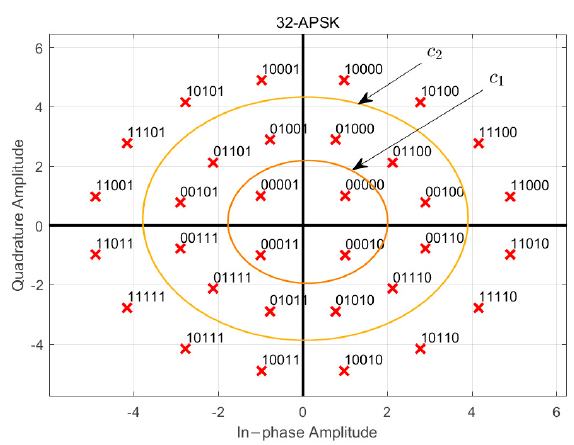
Figure 2. Diagrammatic sketch of ring judgment for 16APSK signals.